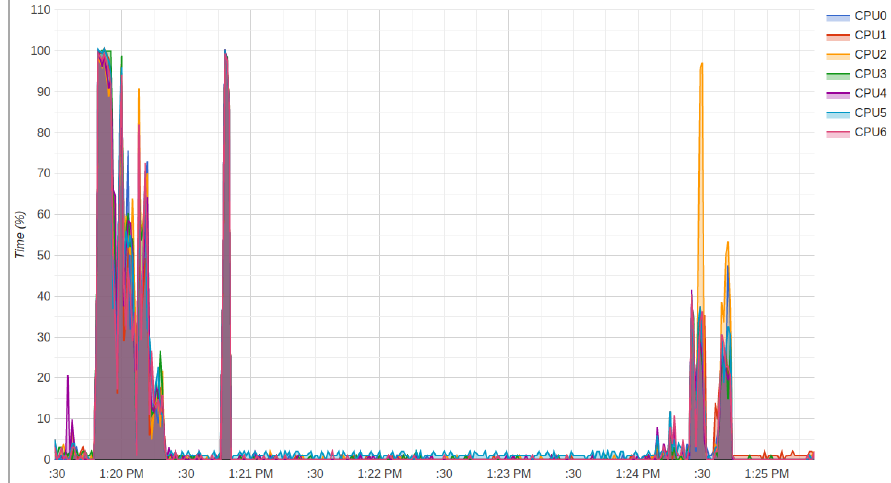
Figure 3. CPU usage of EmuCD without any protocol, 100